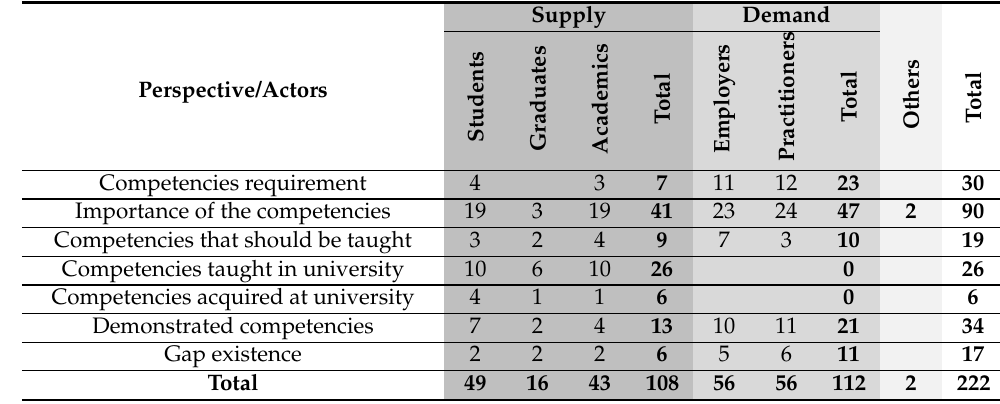
Table 6. Frequencies of participants’